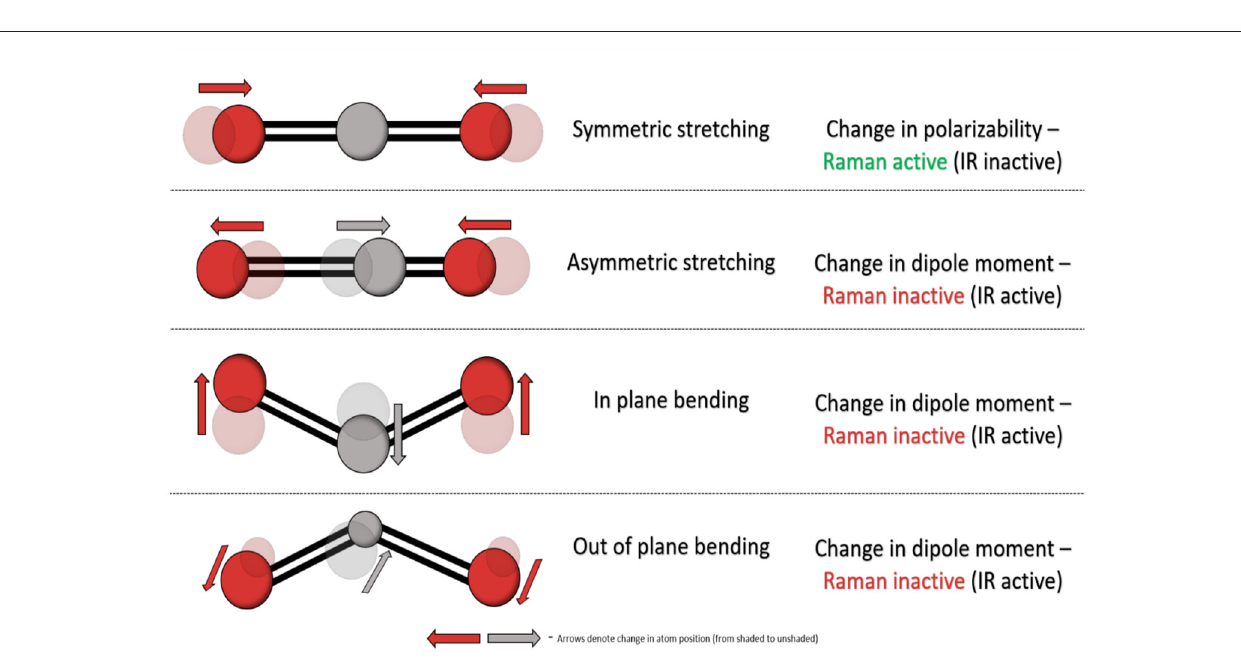
FIGURE 2 | Vibrational modes of CO 2 as an example and their relative FTIR and Raman